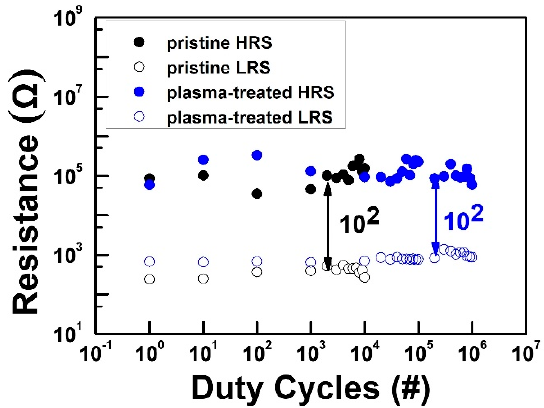
Figure 4. ( a ) Endurance of DC switching cycles and ( b ) retention of the pristine and plasma-treated device.